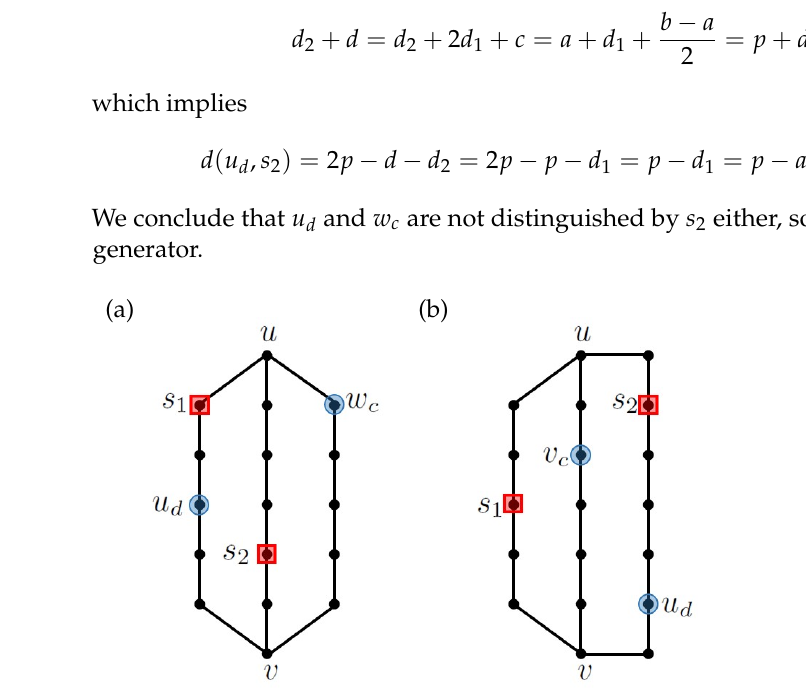
Figure 1. A set S = { s 1 , s 2 } in the proof of Lemma 2: ( a ) case when s 1 ∈ V ( P 1 ) and s 2 ∈ V ( P 2 ) with p = 6, d 1 = 1, d 2 = 4, a = 5, b = 7, c = 1, and d = 3, in which u d and w c are not distinguished by S ; ( b ) case when s 1 ∈ V ( P 1 ) and s 2 ∈ V ( P 3 ) with p = 6, d 1 = 3, d 2 = 2, a = 5, b = 9, c = 2, and d = 8, where u d and v c are not distinguished by S